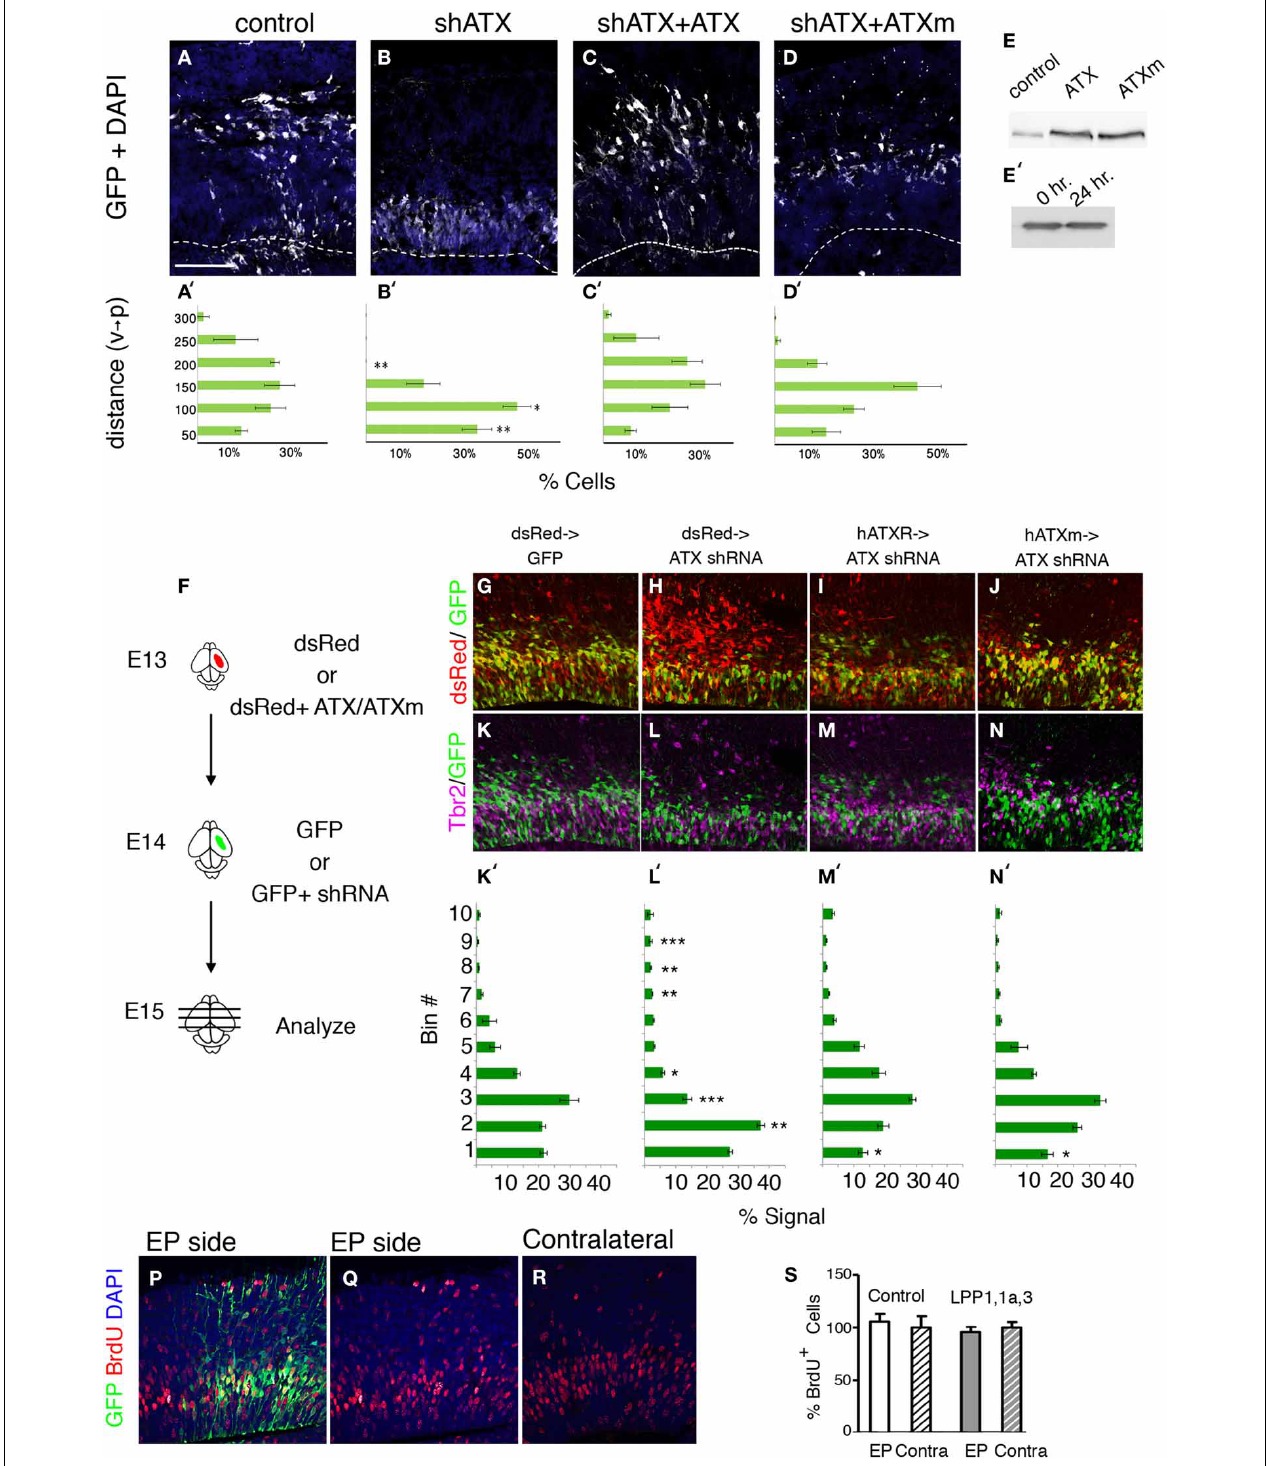
FIGURE 7 | ATX non-cell autonomous, non-catalytic activity. (A–D’) E14 mouse embryos were subjected to ex utero electroporation with a GFP expression plasmid together with either a control shRNA or Atx shRNA. Coronal sections of brains were kept for 2DIV with condition media. (B) Ectopic positioning of cells within the VZ/sVZ can be rescued by addition of